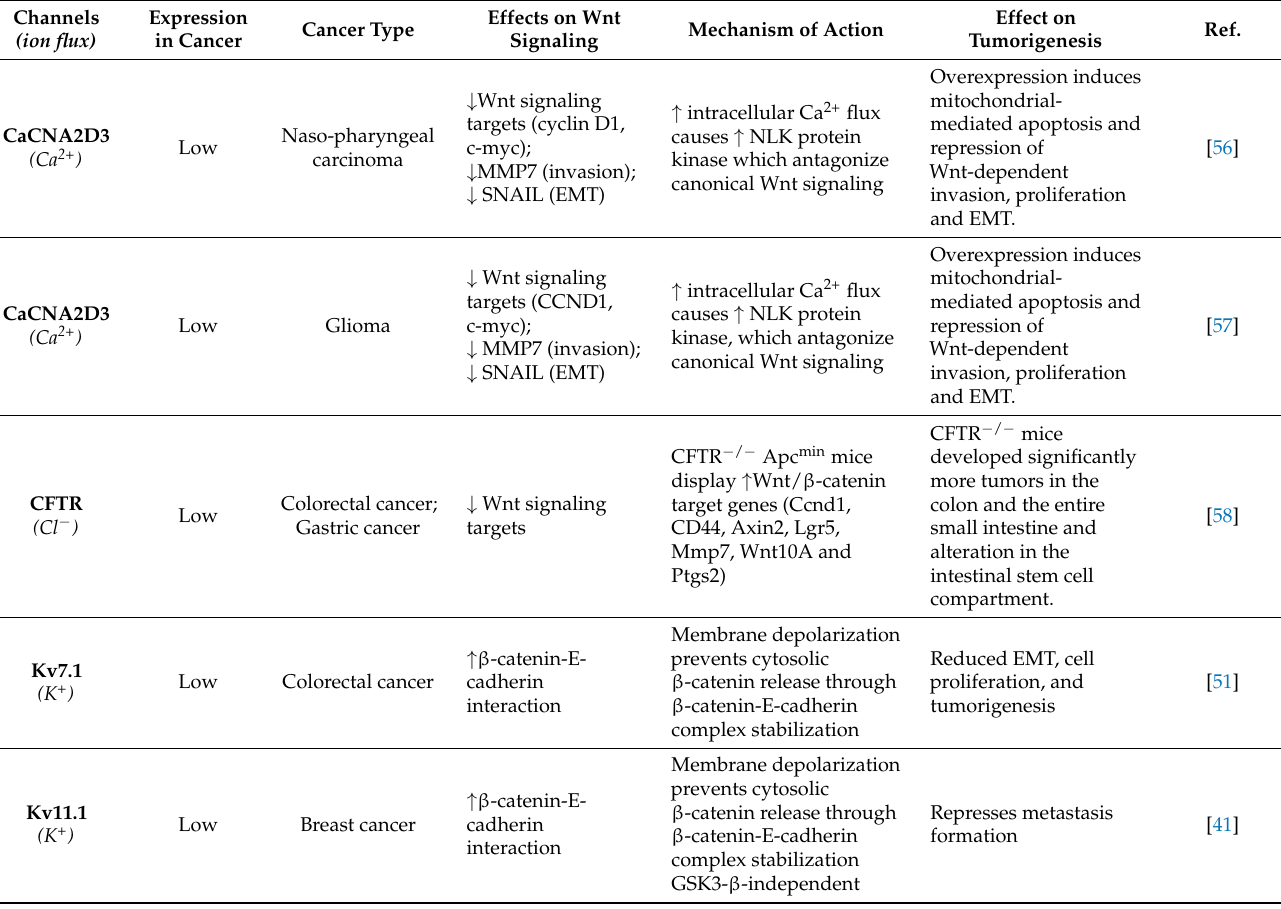
Table 2. Onco-suppressors.